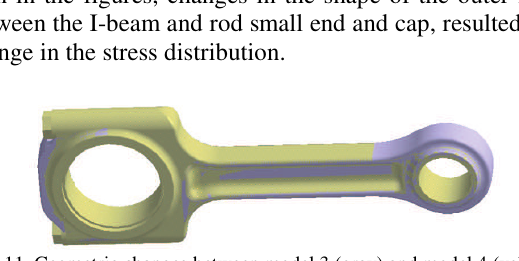
Fig. 11. Geometric changes between model 3 (gray) and model 4 (yellow)